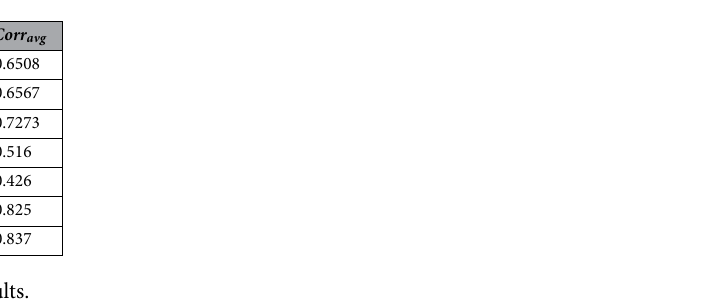
Table 4. Index evaluation